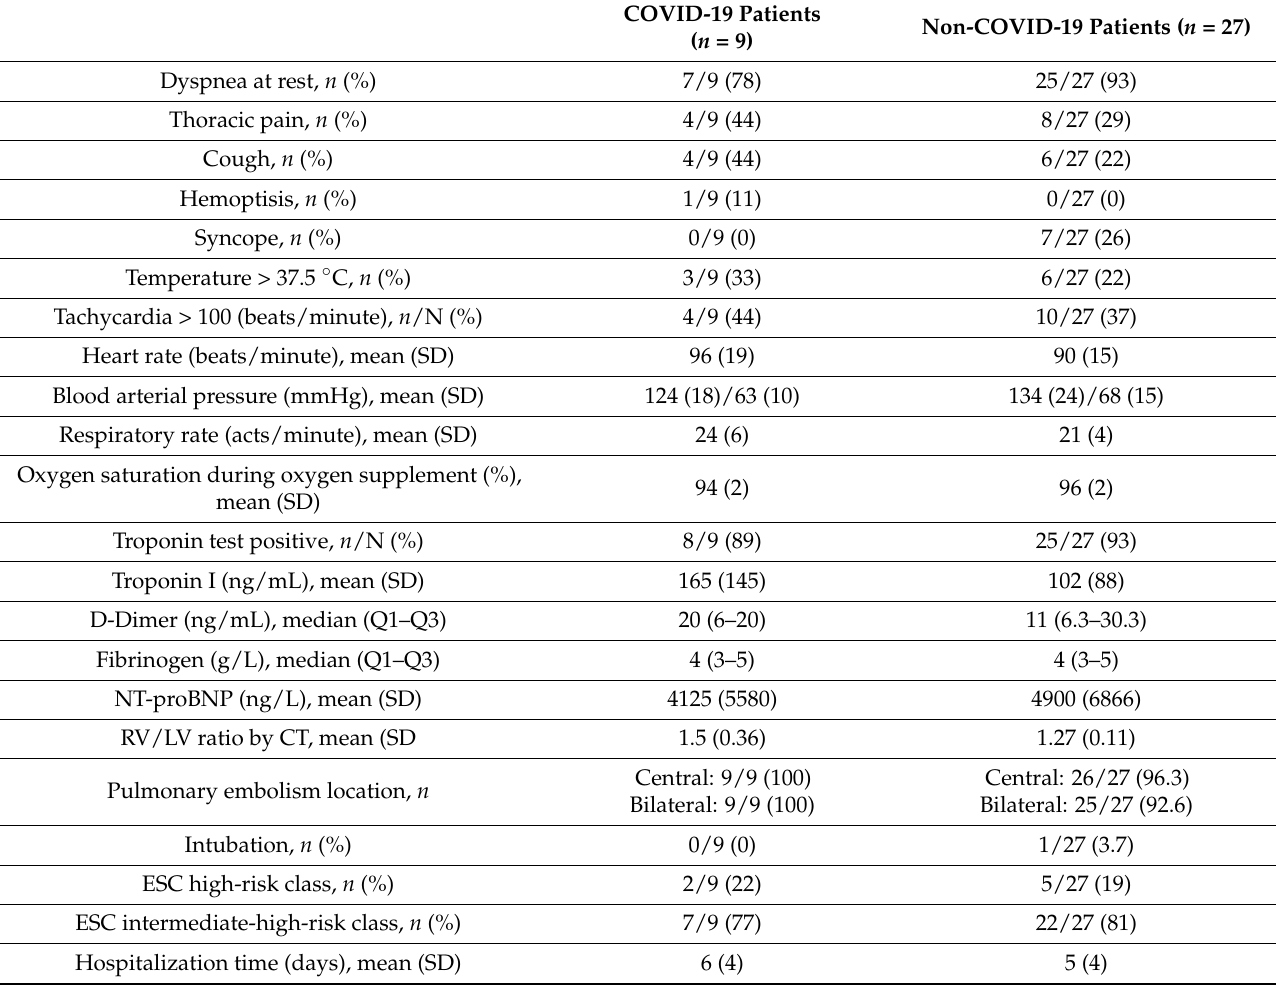
Table 2. Clinical presentation and pulmonary embolism